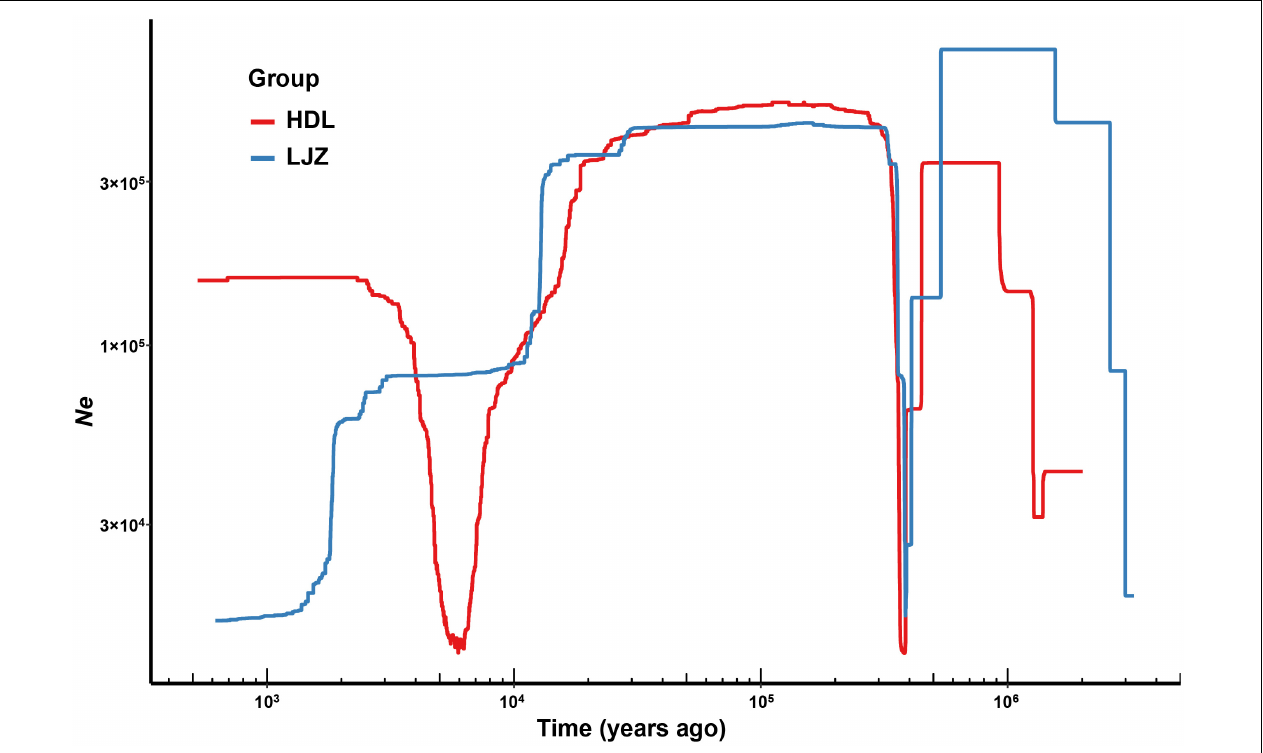
FIGURE 3 | Demographic history of two populations of Lonicera oblata , namely, Heduling (HDL) and Lijiazhuang (LJZ) inferred by Stairway Plot 2. The x-axis indicates the time before the present, and the y-axis represents the historical effective population